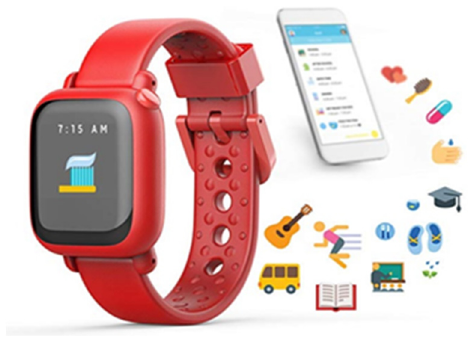
Figure 1. Equipment used: the HeyJoy Octopus